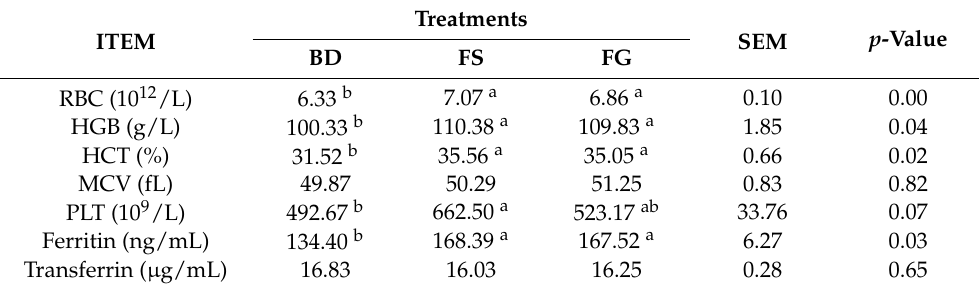
Table 2. Effect of different iron sources on hematological parameters in weaned